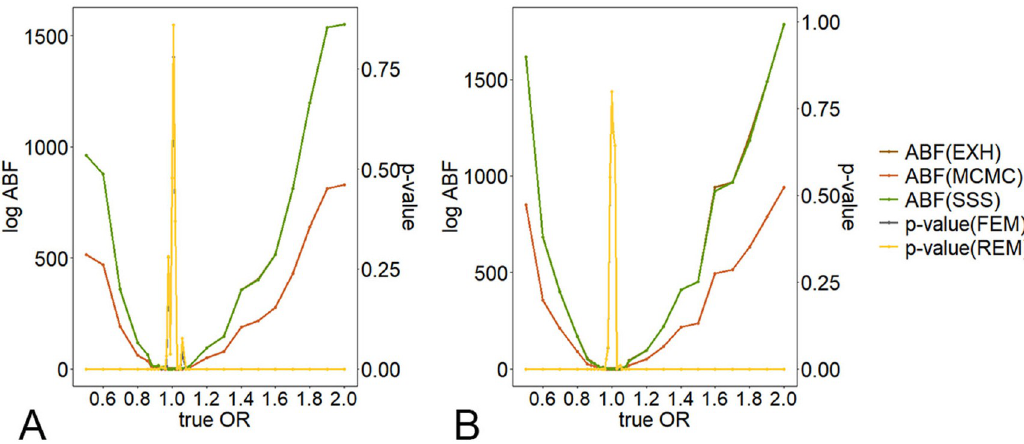
Fig 1. The comparison under various true ORs. Curves representing ABF (EXH) and ABF (SSS) are nearly coincide. Curves representing p -value (FEM) and p -value (REM) are nearly coincide as well. The parameters are set as follows: p = 0.05, f = 0.8 (which equally means MAF = 0.2), the number of studies included ( N ) is set to be 20 (Fig 1A) and 25 (Fig 1B) respectively. For the i -th study, OR i * N (OR, 0.01), the sample size n i is sampled from 100 to 2000 and 100 to 5000,